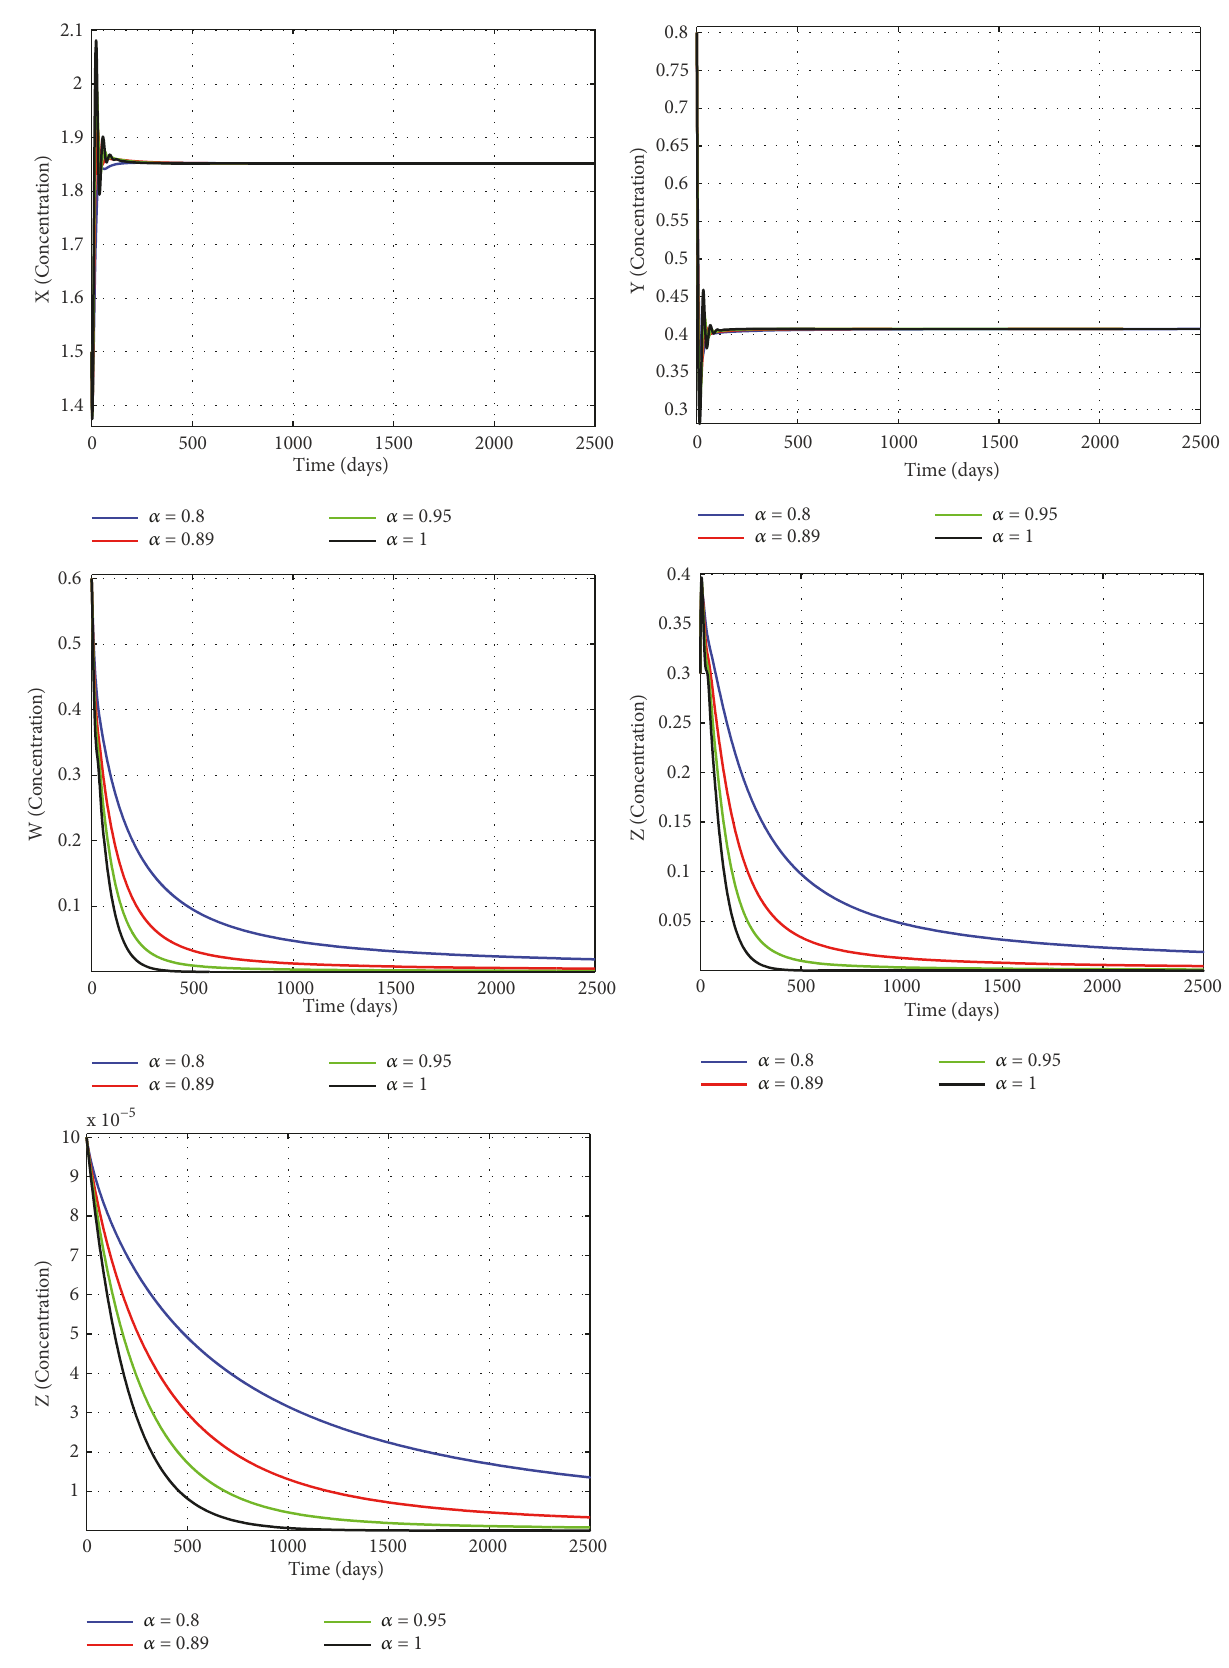
Figure 3: The dynamics of mathematical model of HSCs gene-based therapy for CTL-exhaustion